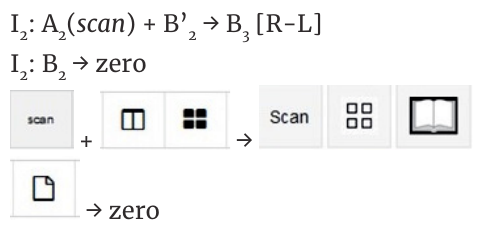
) and moved to the right, to the 2